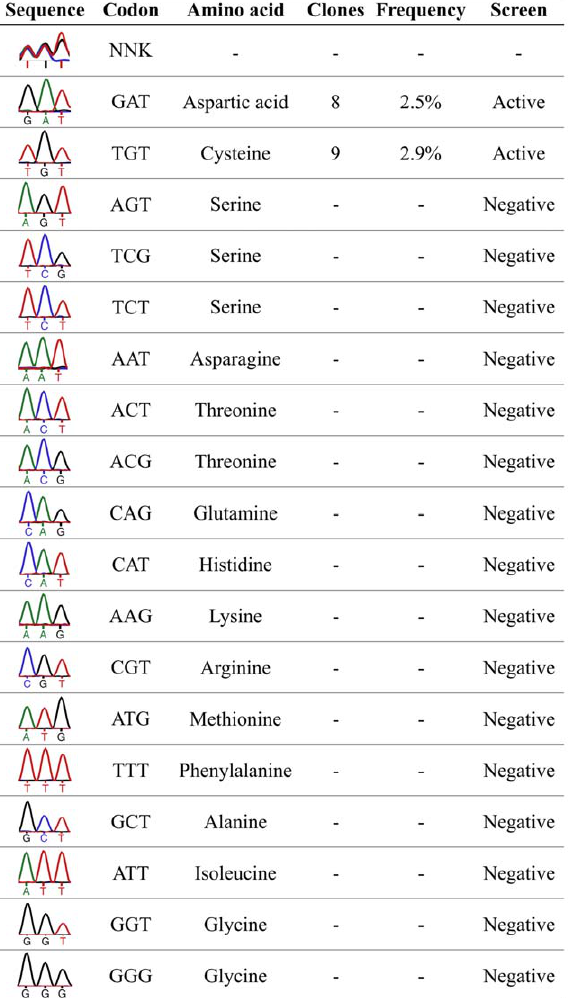
Table 1. Hydrogen evolution